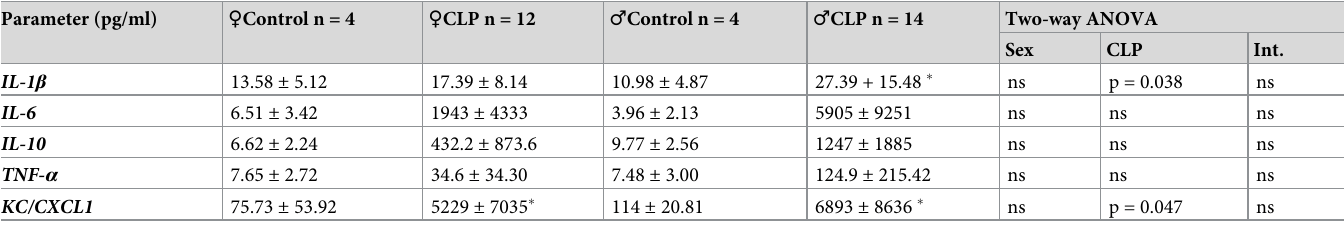
Data are means ± SD. IL, interleukin; KC, keratinocyte-derived chemokine; CXCL1, chemokine ligand-1; TNF, tumor necrosis factor; Int., interaction between sex